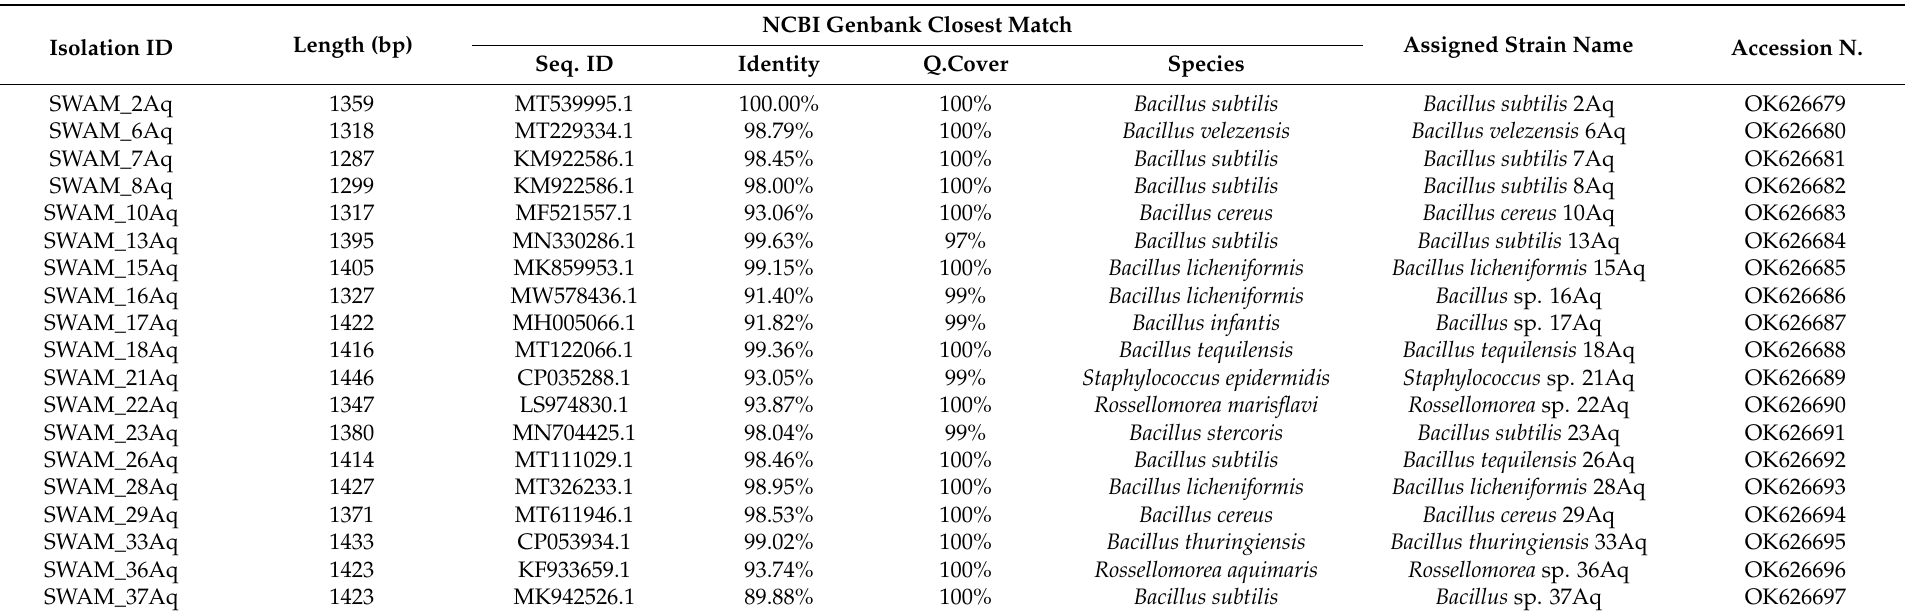
Table 2. Lab isolation name, length of the 16S rRNA gene sequence, nucleotide sequence length of the strains obtained, NCBI GenBank sequence with the highest identity with the isolate’s 16S rRNA gene, assigned strain name, and GenBank accession number of the deposited 16S rRNA